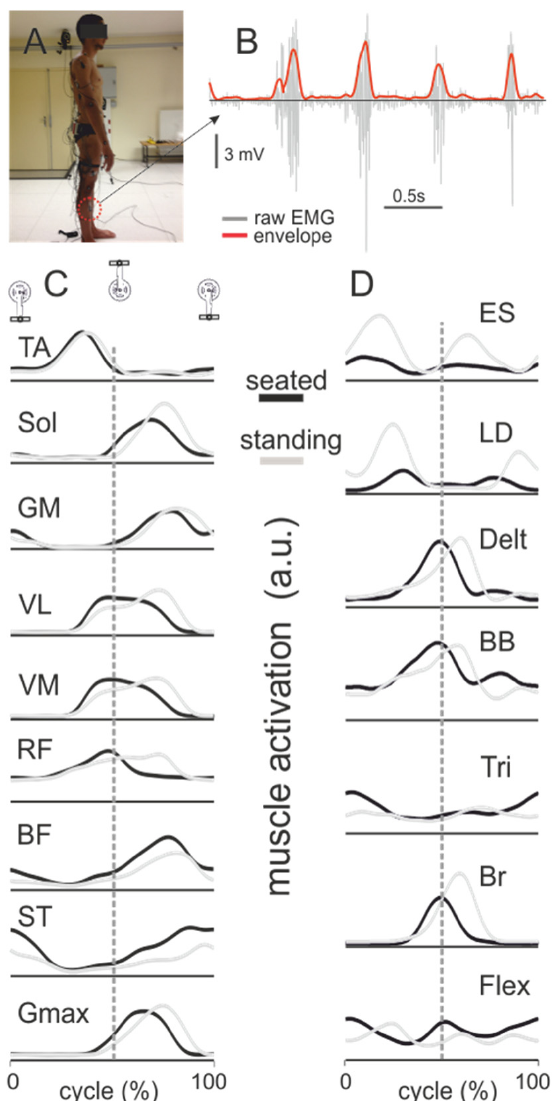
Figure 4. Electromyography (EMG). ( A ). Illustration of a cyclist equipped with a set of electrodes and markers before the cycling tests. The red circle indicates the position of the electrode located on the tibialis anterior muscle. ( B ). Unprocessed EMG signal in gray (raw EMG) superimposed with its envelope in red (integrated EMG). Envelope of the EMG signal for the lower limb ( C ) and upper limb ( D ) muscles when cycling at approximately 500 W (90 RPM) in the seated and standing positions. Data are the average of approximately 15 cycles. EMG analysis allows one to compare the timing and magnitude of the muscle activations between different conditions (here, seated and standing cycling). BB, biceps brachialis; BF, biceps femoris; Br, brachioradialis; Delt, anterior part of deltoideus; ES, erector spinae L4 to L5 level; Flex, flexor digitorum; GM, gastrocnemius medialis; Gmax, gluteus maximus; LD, latissimus dorsi; RF, rectus femoris; Sol, soleus; ST, semitendinosus; TA, tibialis anterior; Tri, triceps lateralis; VL, vastus lateralis; VM, vastus